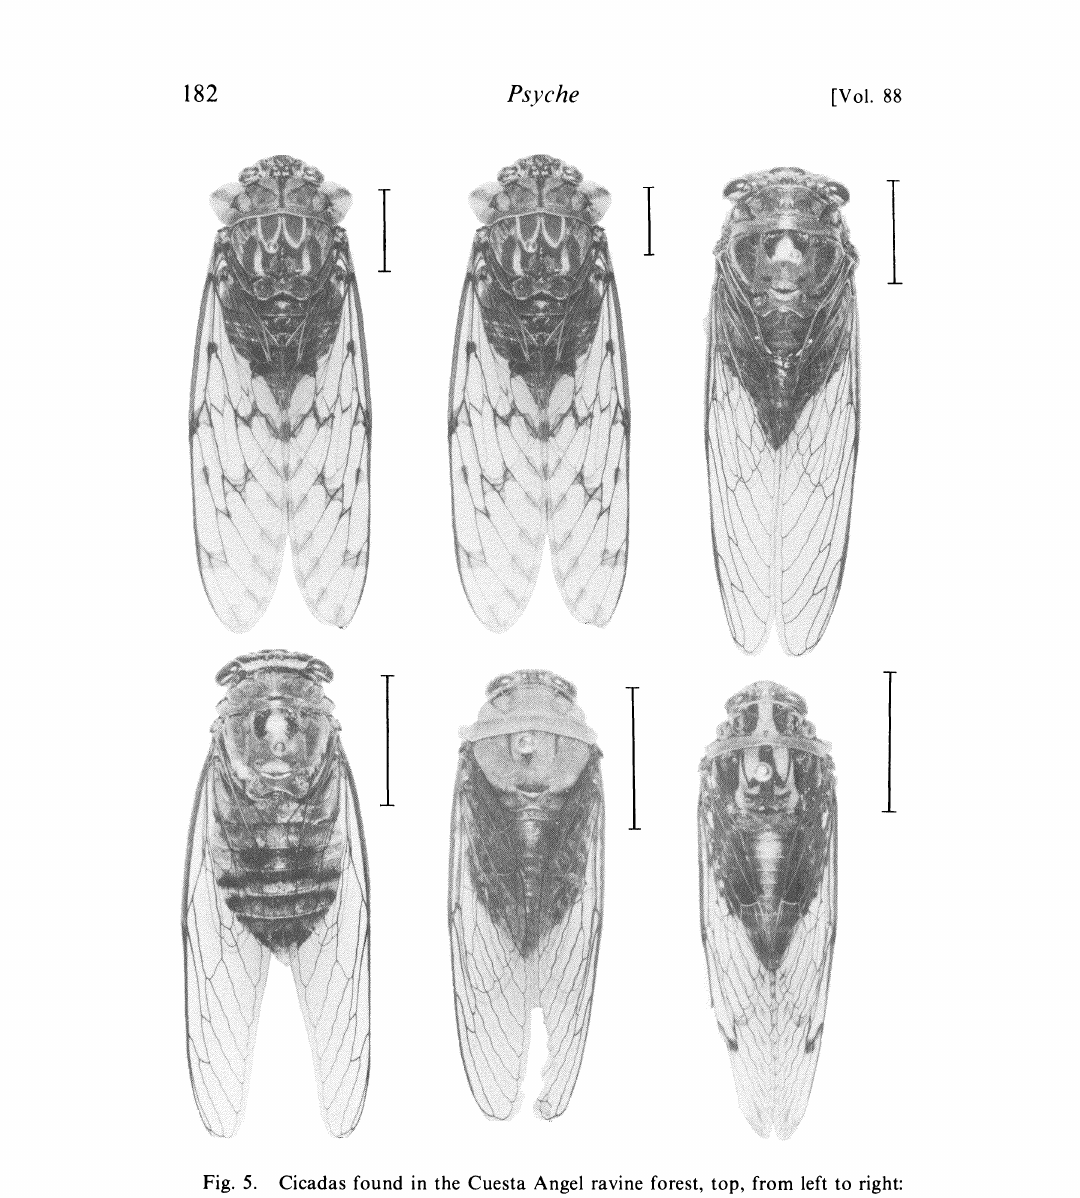
Fig. 5. Cicadas found in the Cuesta Angel ravine forest, top, from left to right: Zammara typanum, Fidicina mannifera, F. sericans; bottom, left to right: F. n.sp., Carineta sp., and C. postica. The vertical black line to the left of each cicada gives the scale of one cm. relative to the body shown in each